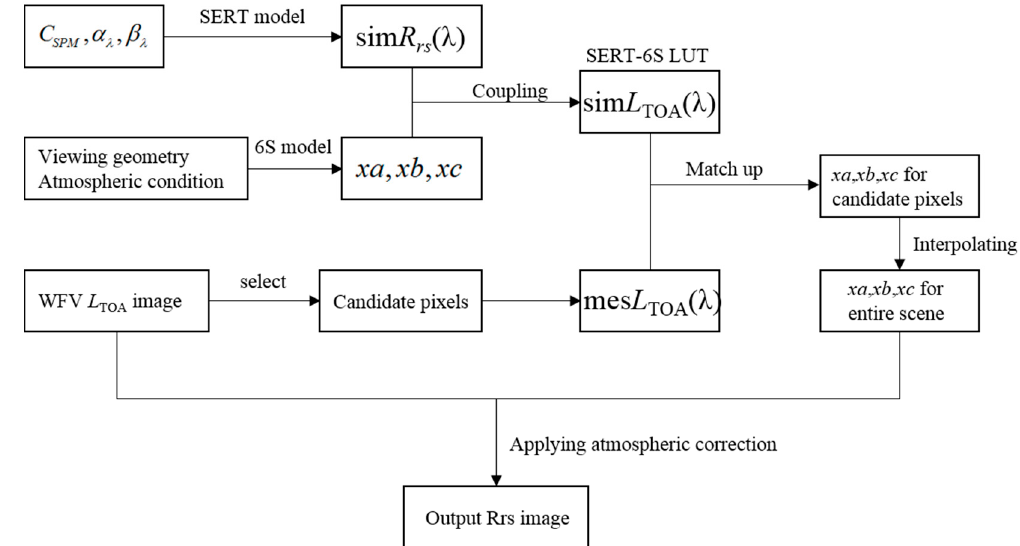
Figure 3. Flow char of the atmospheric correction scheme in this study.